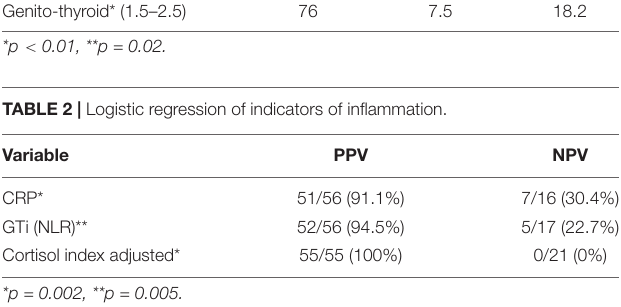
Frontiers in Medicine |